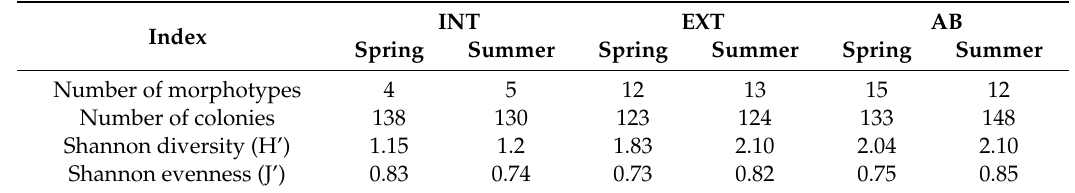
Table 4. Morphotypes, colonies and Shannon diversity indexes of the examined vineyard management methods and